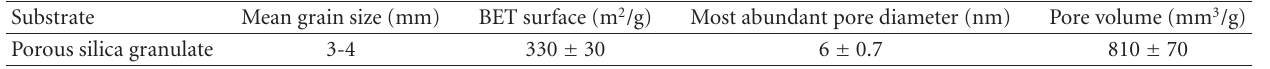
Figure 1: (a) Cut section of the photocatalytic reactor and (b) simplified flow sheet of the setup. Table 1: BET surface and pore characteristics of